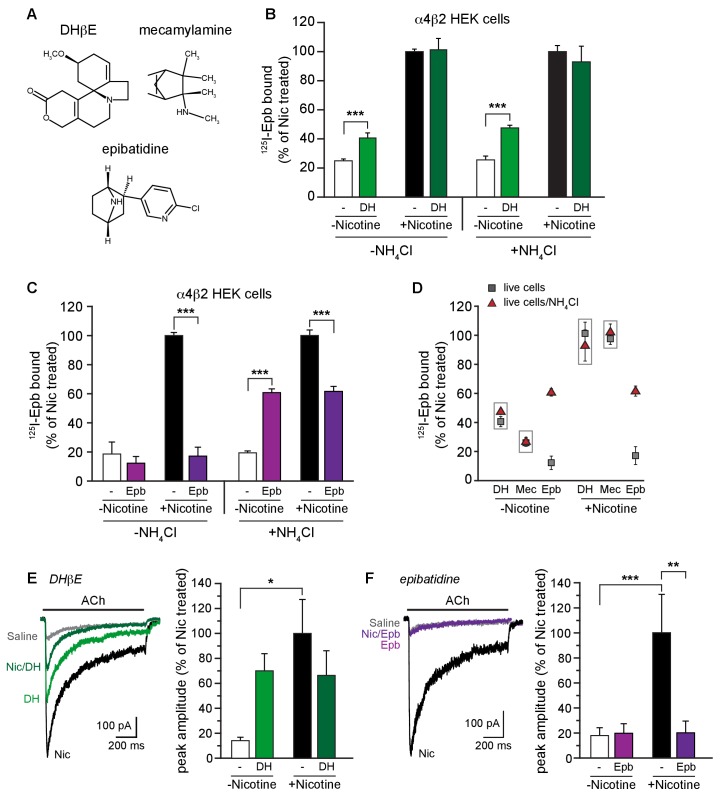
α4β2R weak base ligands exhibit different degrees of intracellular trapping.(A) DHβE, mecamylamine and epibatidine chemical structures. (B) NH4Cl treatment does not alter DHβE (DH) upregulation. 125I-epibatidine binding performed on live α4β2R-expressing cells without (left) or with (right) NH4Cl treatment as in Figure 1D. Cells were treated for 17 hr with 100 μM DHβE with or without 10 μM nicotine (n = 6: -NH4Cl; n = 4: +NH4Cl)). The profile was similar to cells washed with PBS, indicating no effect of pH on DHβE. (C) Intact cells were treated with 30 μM epibatidine (Epb) and 125I-epibatidine binding were performed after incubating the cells with (left) or without (right) 20 mM NH4Cl/PBS (n = 3). Column graphs in (B, C): ***, p<0.001 by one-way ANOVA with Bonferroni’s multiple comparison test. n indicates number of independent determinations on separate days and cultures. (D) A distribution plot comparing upregulation (125I-epibatidine binding) by DHβE, mecamylamine and epibatidine before and after disruption of intracellular pH gradient by various agents that raise pH in intact cells. Each point represents the mean and s.e.m from the indicated columns in Figure 3B,C with the exception of the mecamylamine data, where the data are not displayed elsewhere, and the points are the means and s.e.m (n = 4) where n indicates number of independent determinations on separate days and cultures. (E) ACh-evoked currents following 17–20 hr treatment of α4β2-expressing HEK cells with vehicle, nicotine, DHβE (DH, 100 μM), or nicotine and DHβE. The number of recordings were 17, 21, 15 and 21, respectively. DHβE appeared to upregulate ACh function but the currents were variable in their amplitude and the mean was not statistically different from the vehicle group. No attenuation of nicotine upregulation was observed with DHβE. (F) Epibatidine (Epb, 30 μM) shows effects on ACh currents similar to that of varenicline. Current amplitudes were similar to the vehicle control when cells were incubated with epibatidine alone, but co-incubation with nicotine prevented functional upregulation. The number of recordings were 14, 22, 17 and 24, respectively. In all the column graphs: *p<0.05; **p<0.01; ***p<0.001 by one-way ANOVA with Tukey’s multiple comparison test; n indicates the number of experimental repetitions. Columns show group mean and error bars are the s.e.m.